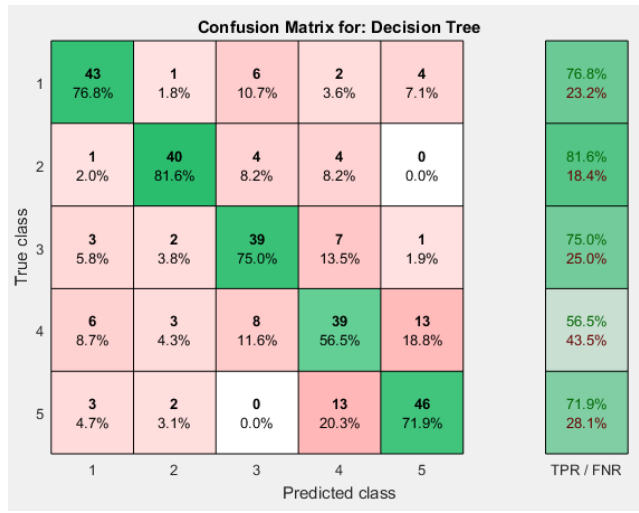
Figure 10. Decision Tree (Complex Tree) Confusion Matrix.